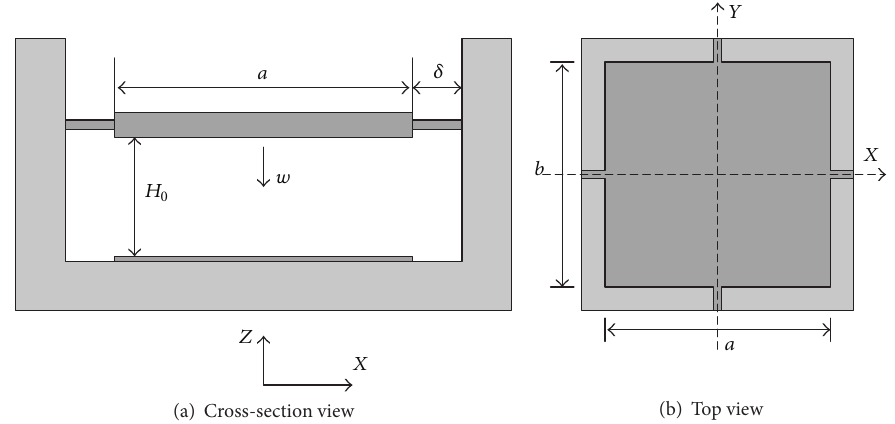
Figure 1: Schematic diagram of a normal moving MEMS